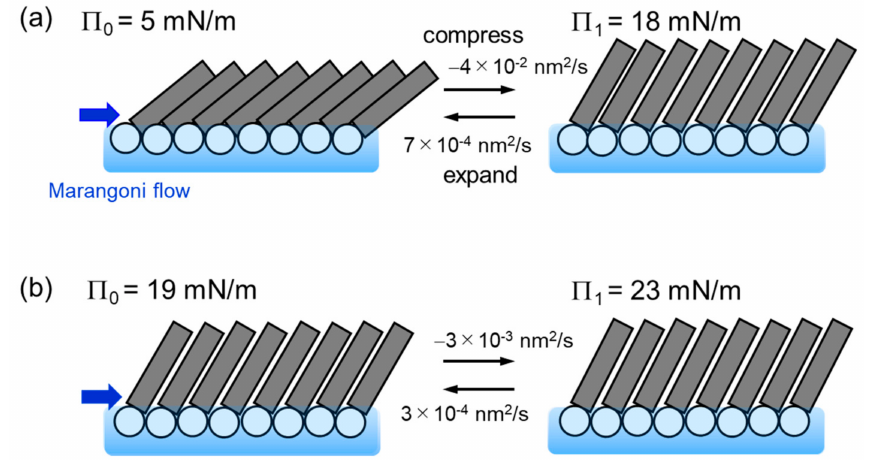
Figure 10. The schematic illustration of the behavior of DSPC molecules during the spontaneous oscillation of surface tension. ( a ) DSPC monolayer at Π 0 = 5mN/m. The tilt angle changes from 51 ◦ to 30 ◦ during the oscillation. ( b ) DSPC monolayer at Π 0 = 19mN/m. The tilt angle changes from 30 ◦ to 27 ◦ during the oscillation. The rate of compression and expansion are estimated from the oscillation